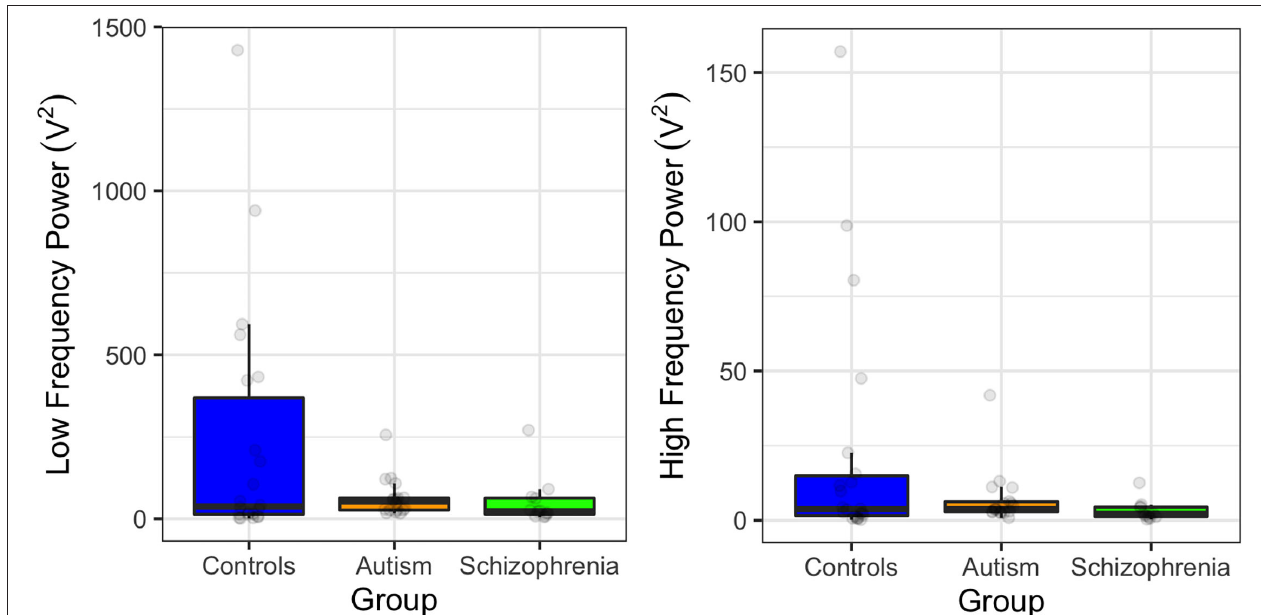
FIGURE 2 | Power at low frequencies (0.04–0.15Hz; left) and at high frequencies (0.15–0.4Hz; right) in controls, individuals with autism, and individuals with schizophrenia. Error bars show 95% confidence intervals.